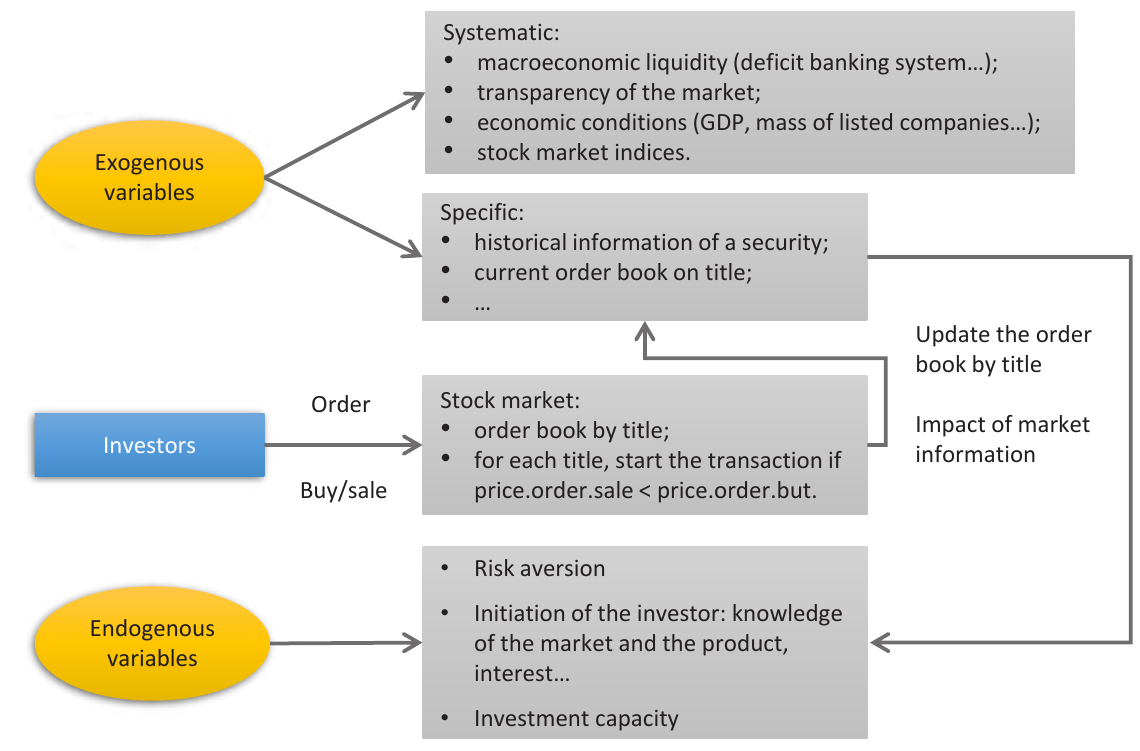
Figure 1. Schematic diagram of the buying/selling decision-making by the agent